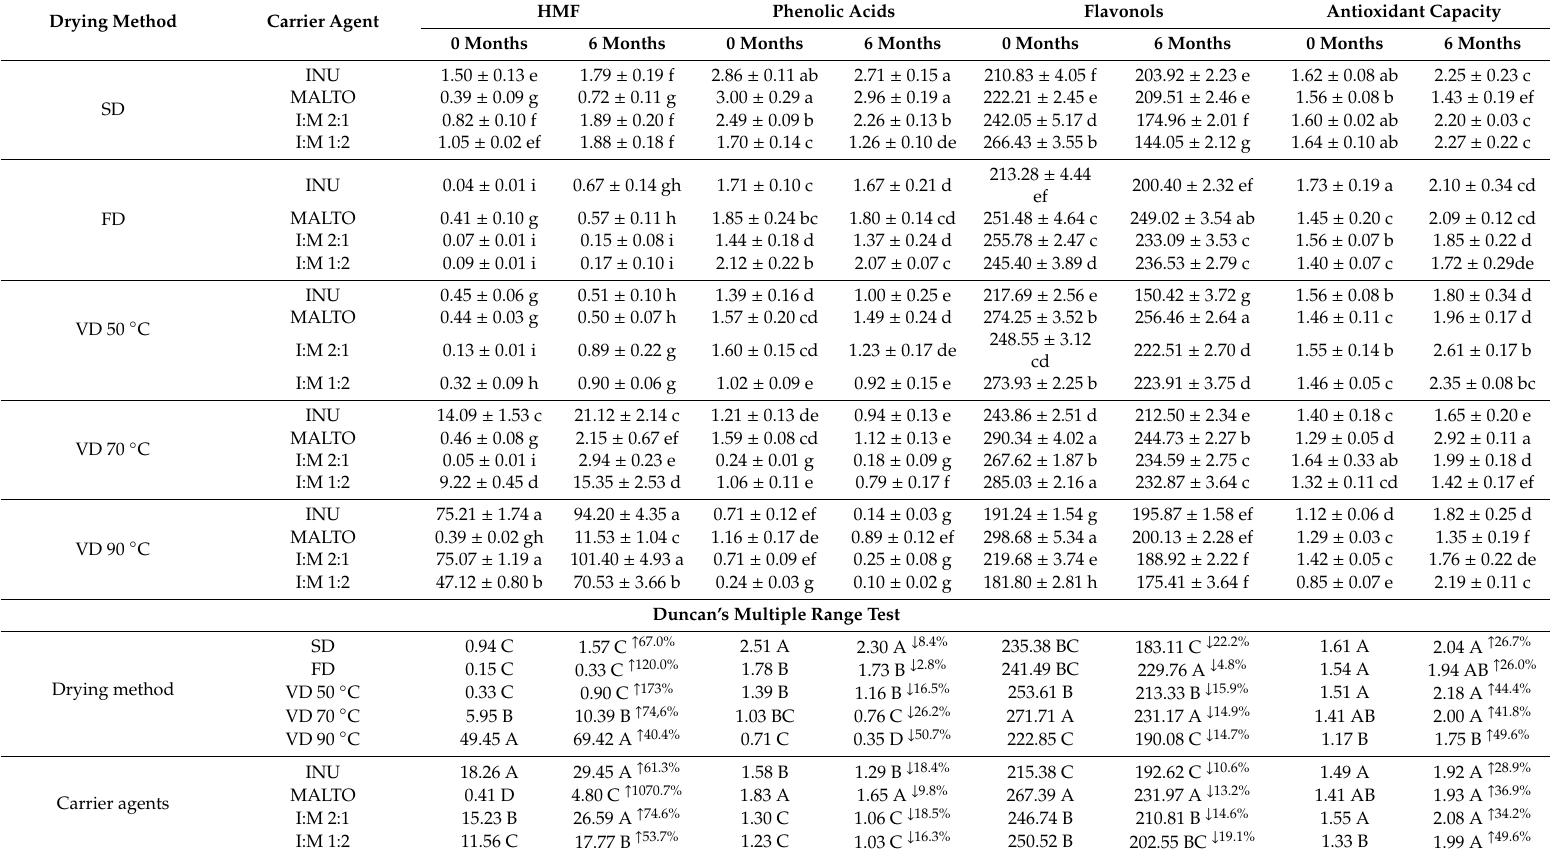
Table 3. Content of hydroxymethylfurfural (HMF) and phenolic compounds (mg / 100 g DM) and antioxidant capacity (mmol Trolox / 100 g DM) of sea buckthorn juice